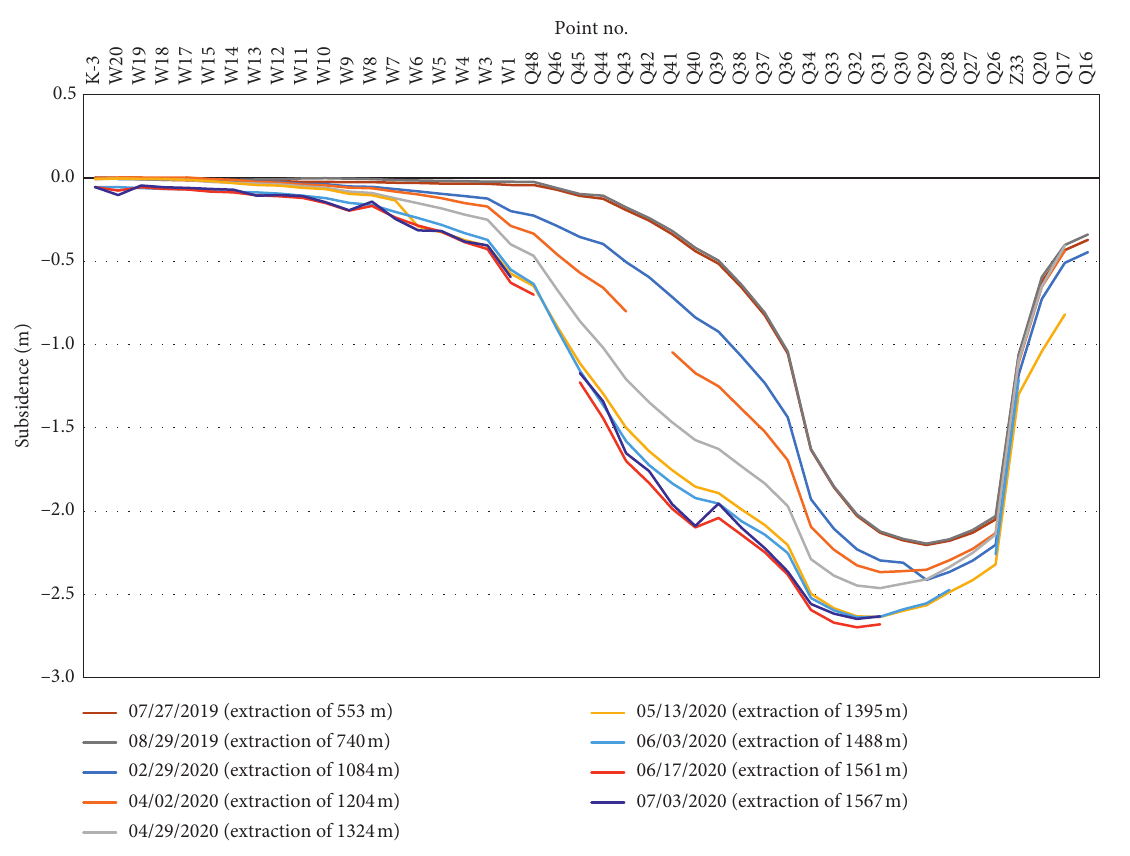
Figure 12: Profile of Line Q along the dip of 31102 panel. Table 7: Subsidence velocity of point